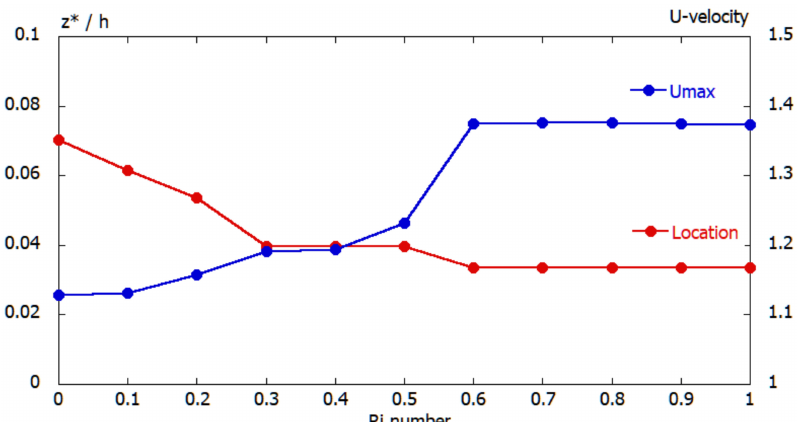
Figure 13. Maximum U-velocities at the top of the steep hill and heights under various stable conditions.